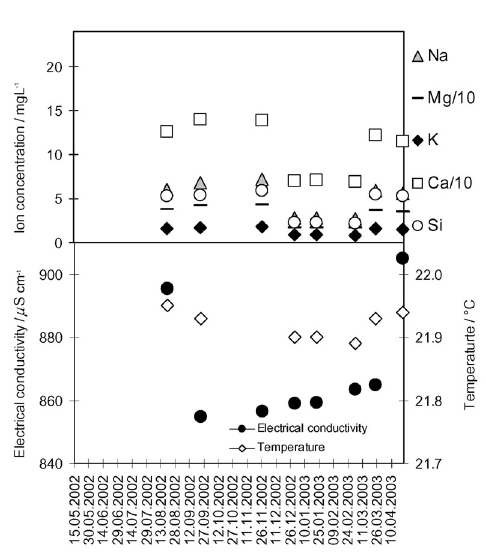
Fig. 8. Ion concentrations (mgL –1 ), electrical con- ductivity ( µ Scm –1 ) and water temperature (°C) in the thermal spring at Bled between May 2002 and April